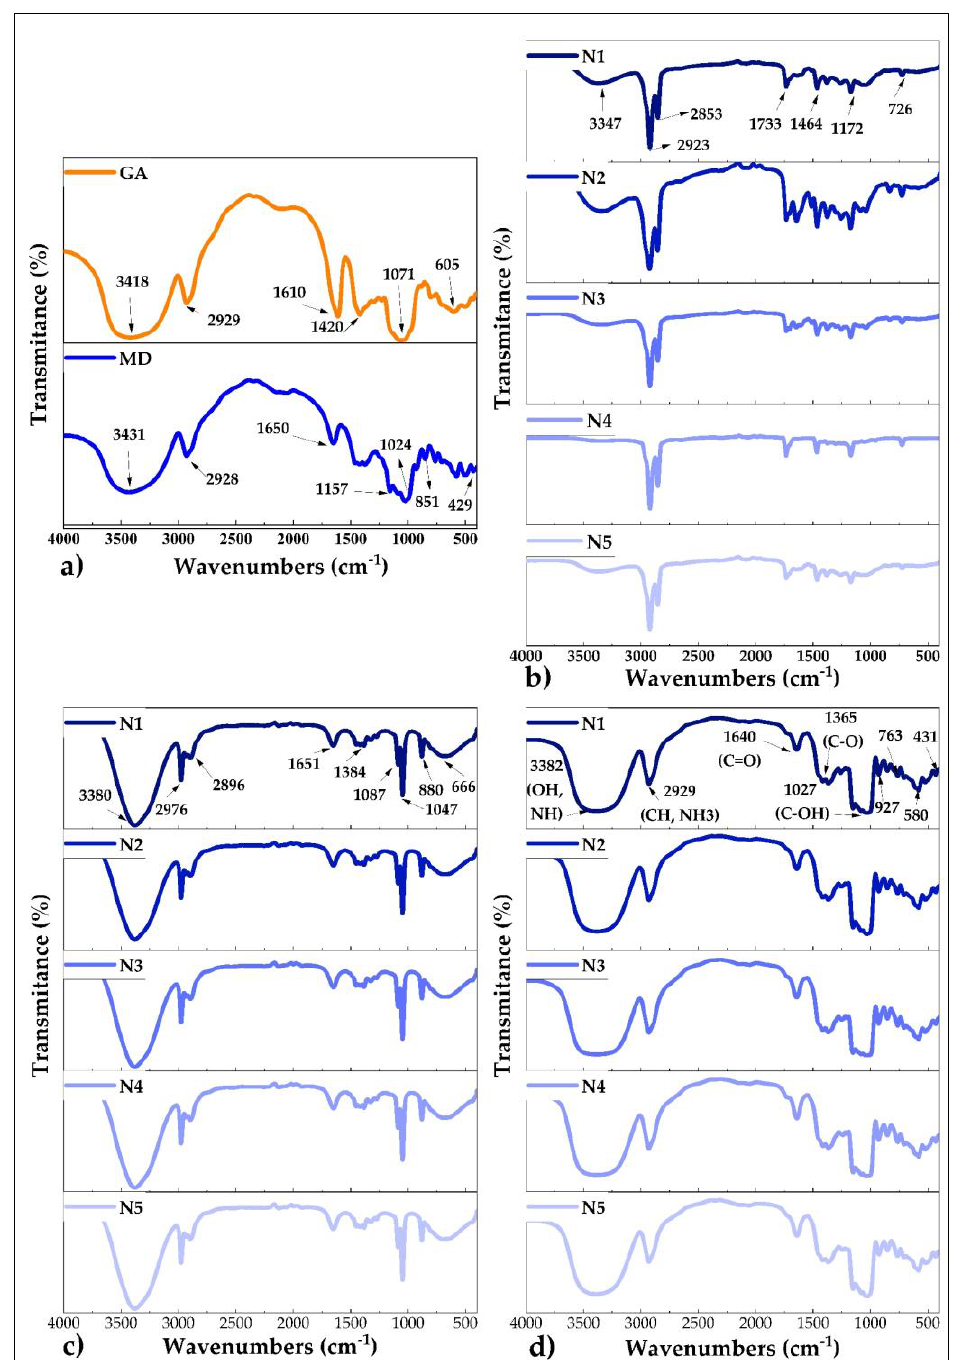
Figure 8. FTIR spectra; a) gum arabic (GA) and maltodextrin (MD); b) raw propolis; c) ethanolic extracts propolis; and d) nanoencapsulates.